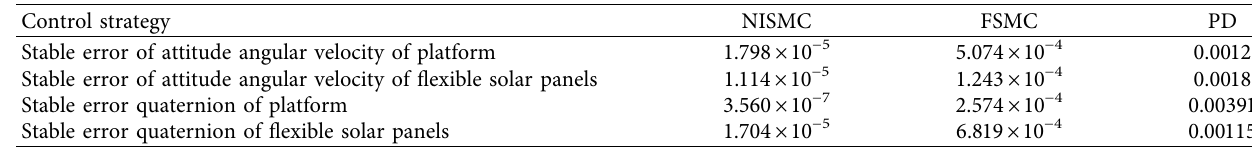
Figure 11: Comparison of errors of attitude angular velocity of flexible solar panels. Table 1: Parameter control